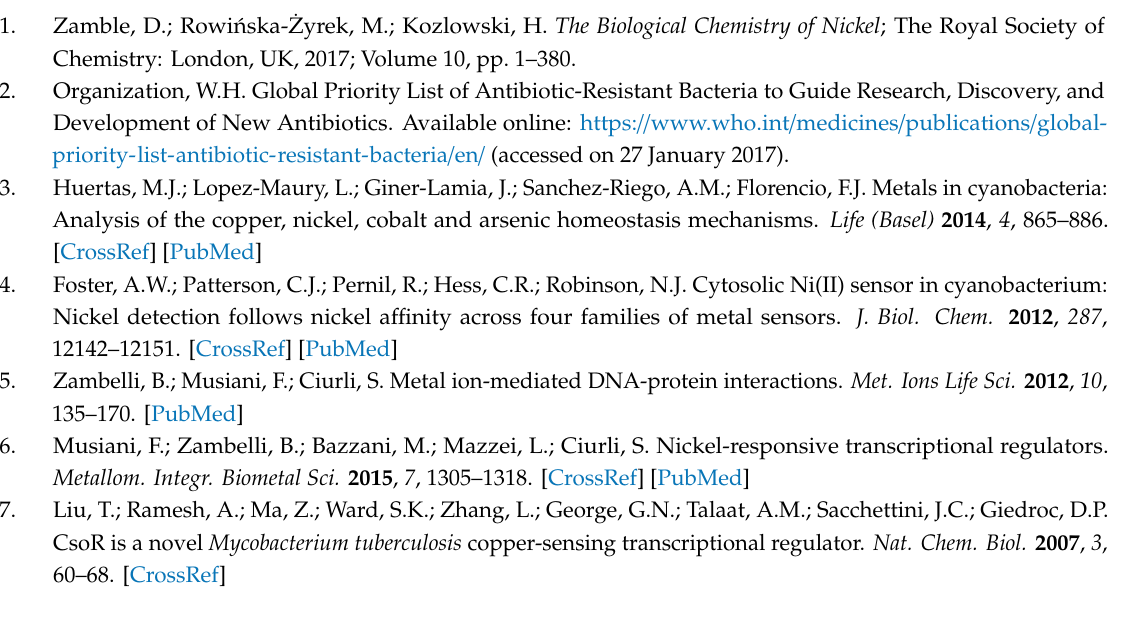
Figure S1: RcnR / CsoR family solved structures. Figure S2: Ribbon diagram and inertia ellipsoid of SyInrS in the apo and holo conformations. Figure S3: Detail of the α -helices α 1 and α 2 rotation occurring during the apo to holo conformational transition. Figures S4 and S5: Results for the modelling of Ni(II) bound SyInrS starting from the protein in the apo and holo conformation, respectively. Table S1: CsoR / RcnR family representative sequences. Tables S2 and S3: Structural analysis of the models of Ni(II) bound Sy InrS generated starting from the protein in the apo and holo conformation,